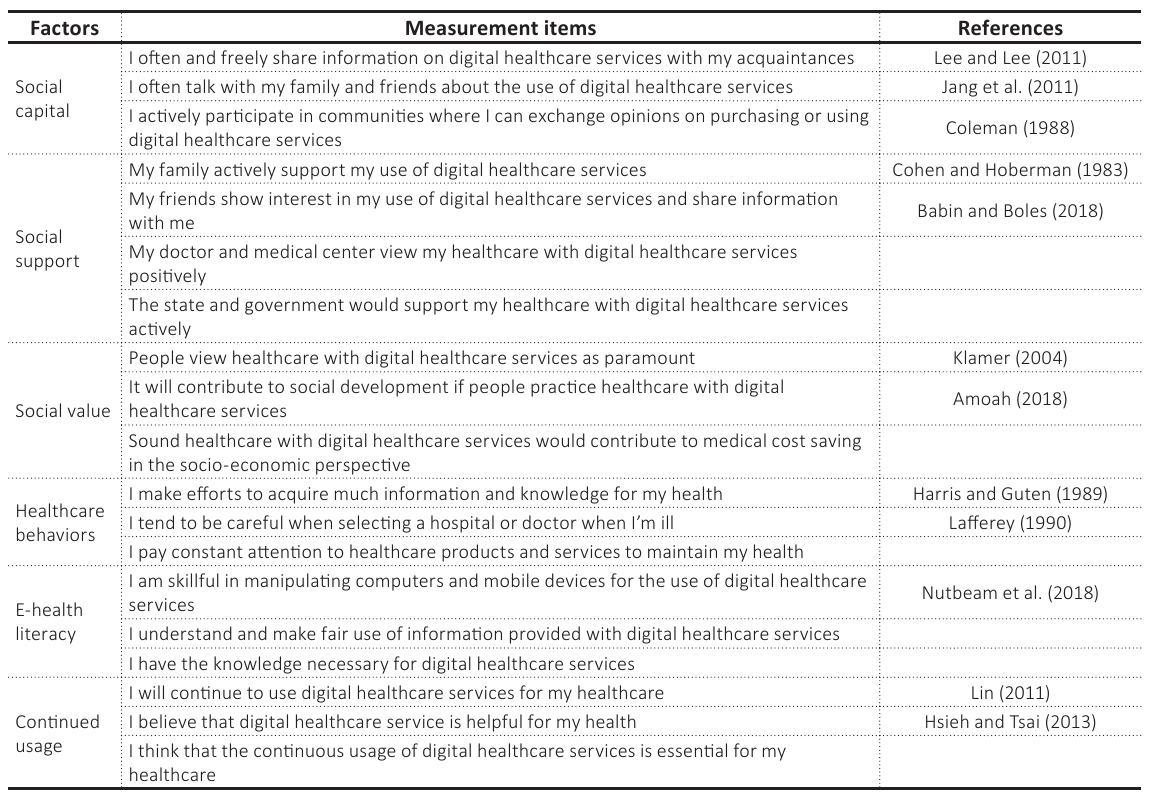
Table 1. Variable definitions and measurement